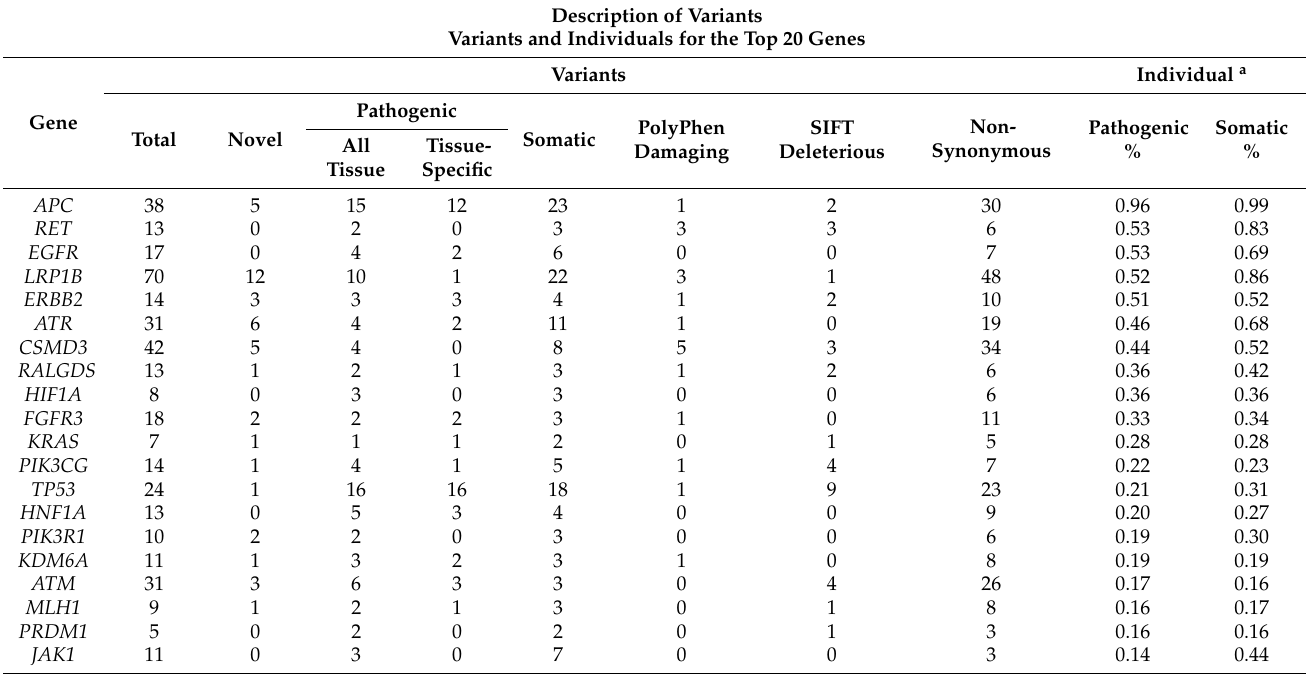
Table 2. List of twenty genes with variants in order of frequency in the sample